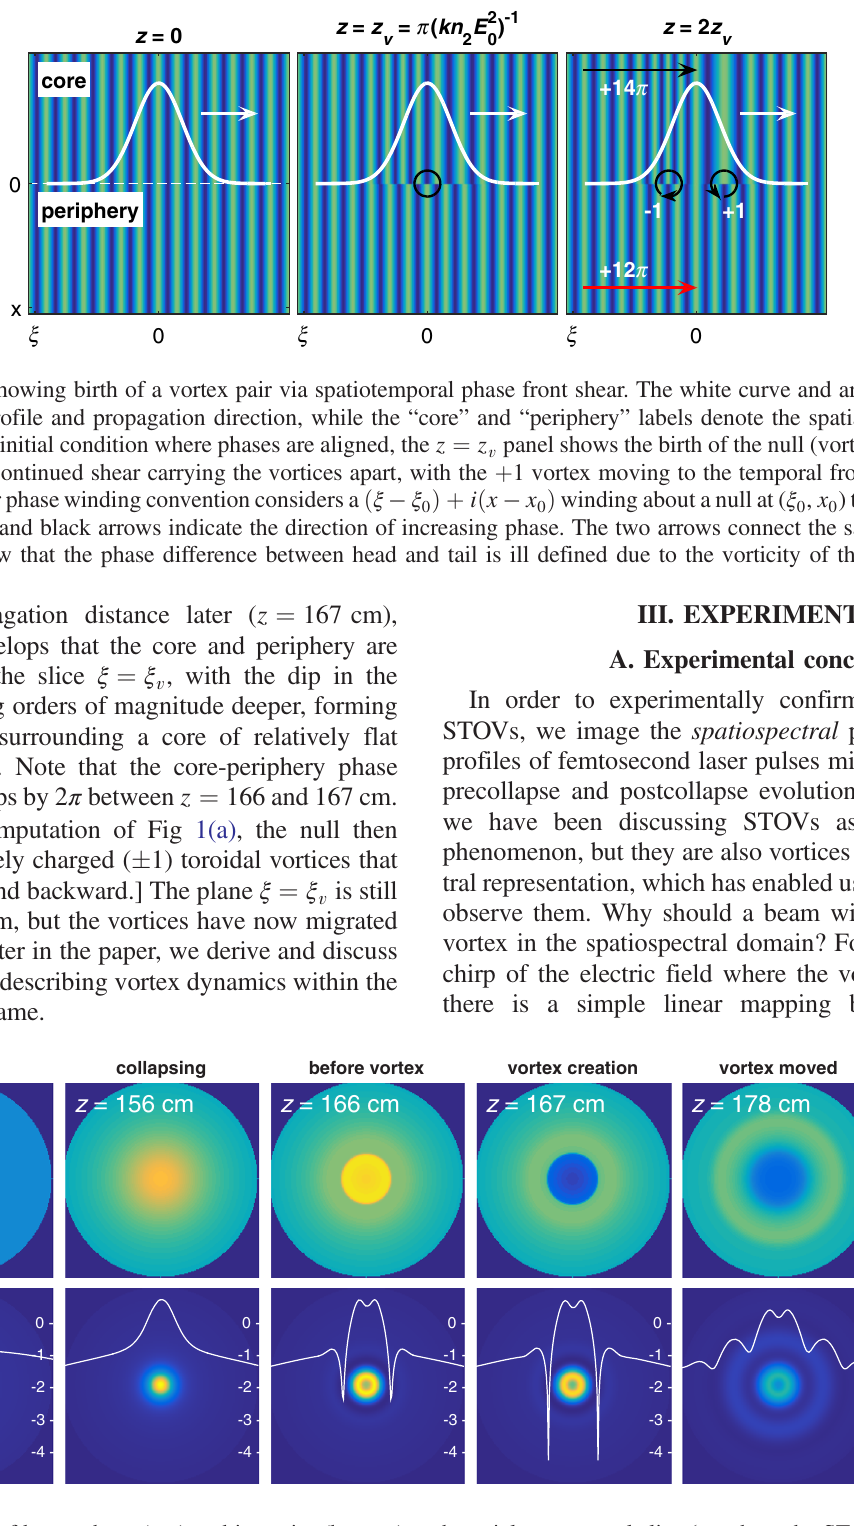
, where the STOV pair first appears. v 6 . 4 ), pulse cr ¼